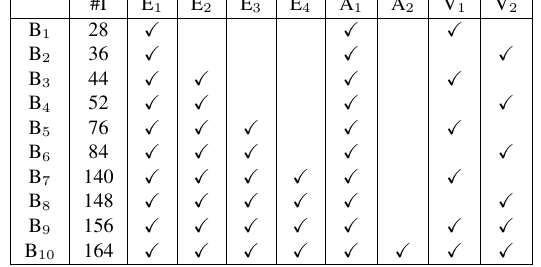
Figure 7: RMSE computed for each ring of targets, identified by their radial distance, for Scenario